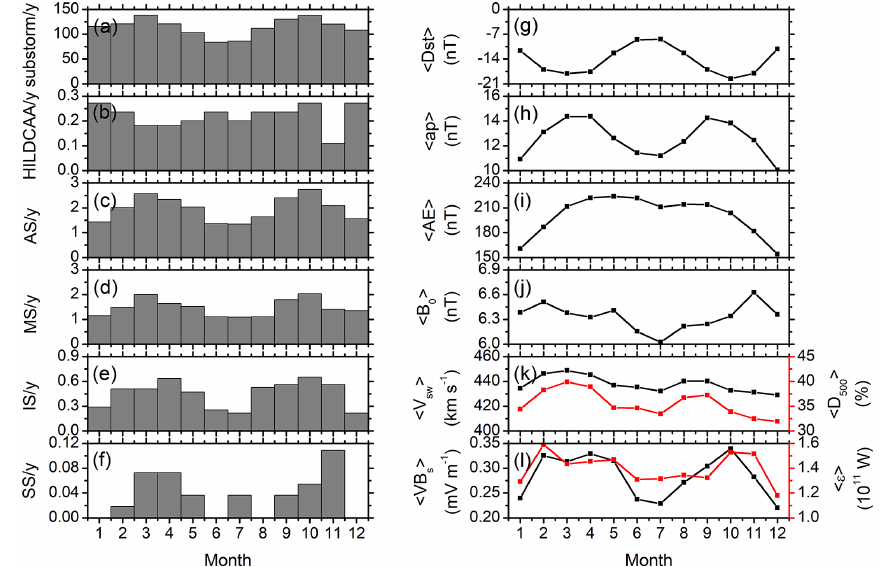
Figure 2. Monthly superposed variations. Left panels, from top to bottom, show the total numbers divided by years of observation of (a) substorms, (b) HILDCAAs, (c) all storms (AS), (d) moderate storms (MS), (e) intense storms (IS) and (f) super storms (SS), respectively. Right panels, from top to bottom, show the monthly mean values of the (g) geomagnetic Dst, (h) ap, and (i) AE indices; (j) IMF B 0 ; (k) V sw (black, legend on the left) and D 500 (red, legend on the right); and (l) VB s (black, legend on the left) and (cid:15) parameter (red, legend on the right),